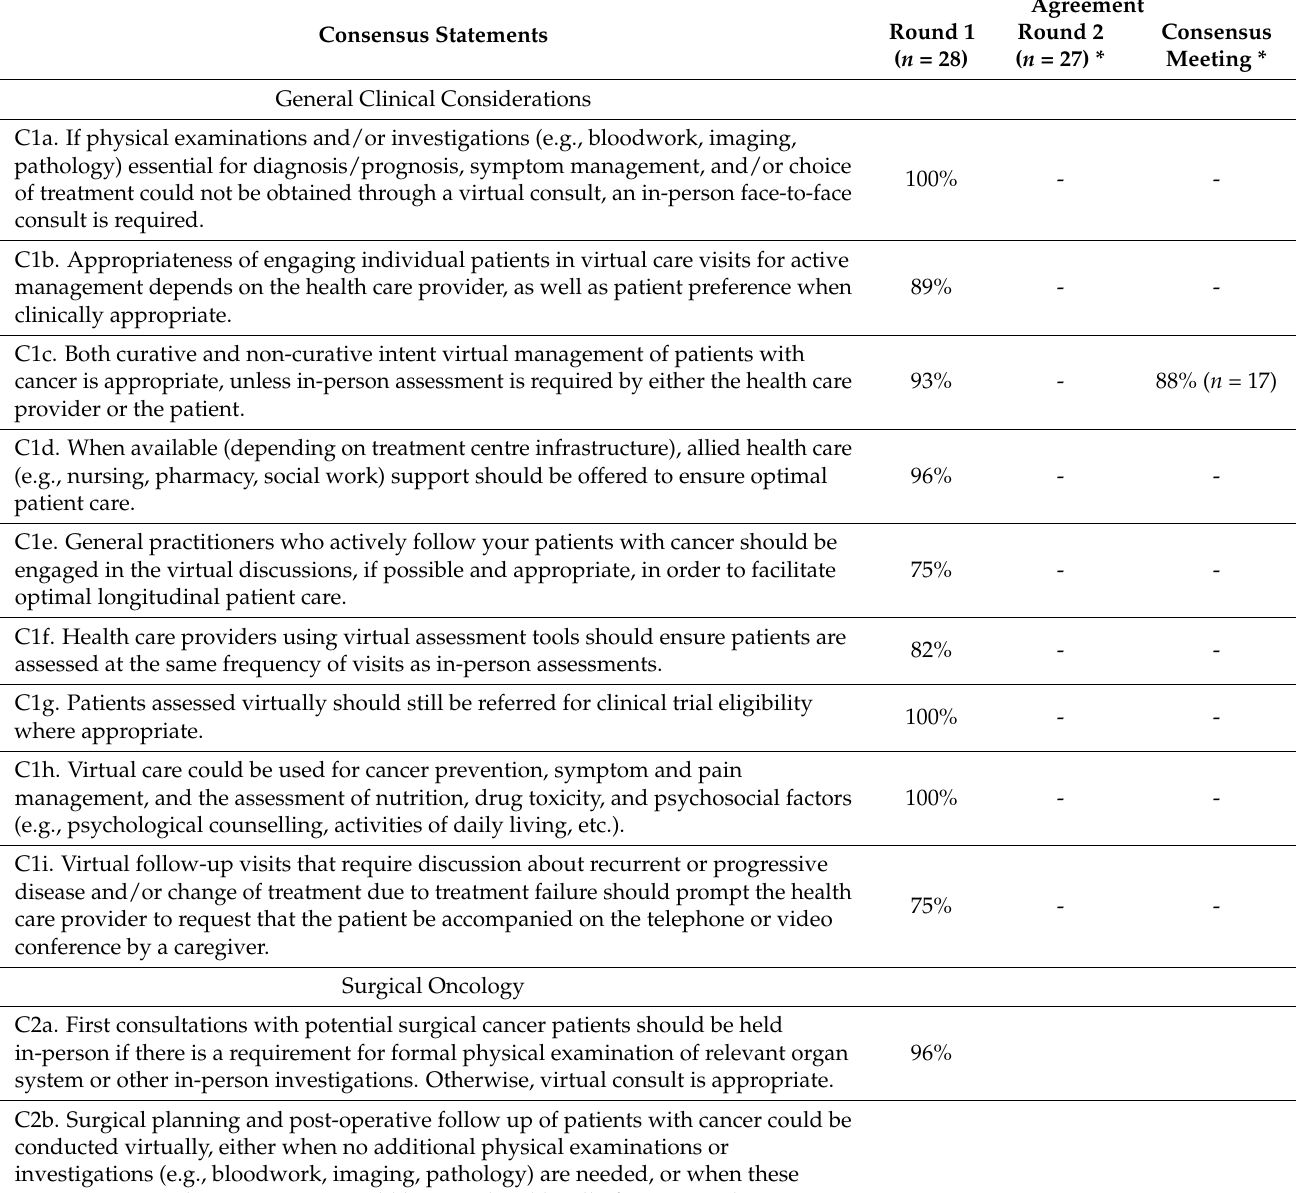
Table 3. Section C—Clinical characteristics, active management, and